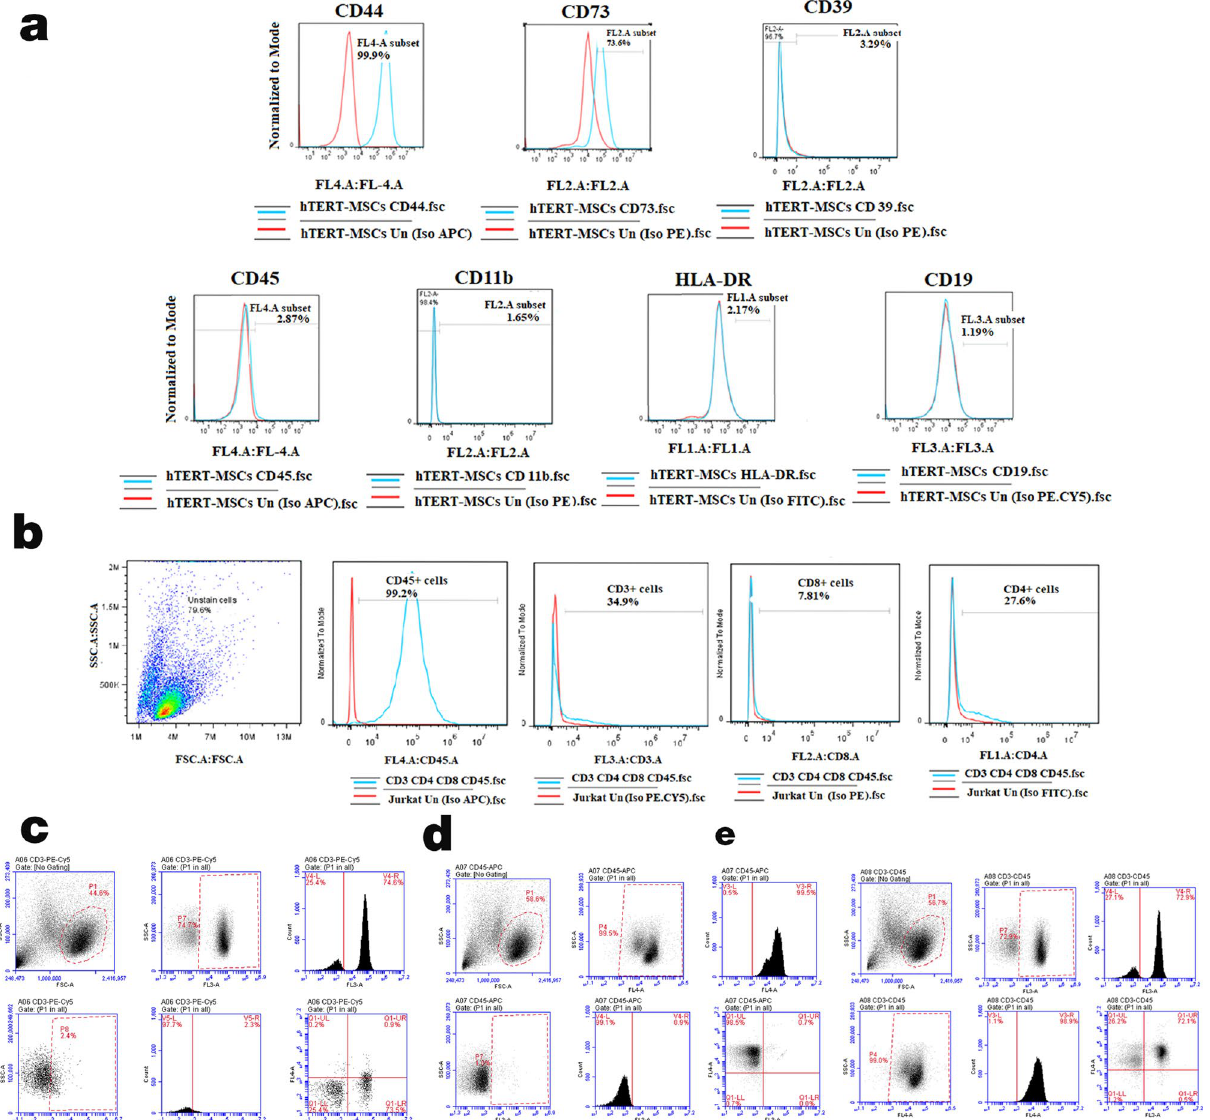
Figure 1. Flow cytometric characterization of different cells. ( a ) hTERT-MSCs: hTERT-MSCs were positive for CD44 and CD73, but they were negative for CD45, CD11b, HLA-DR and CD19 markers. ( b ) Jurkat cells: Most (99.2%) of the Jurkat cells express the hematopoietic cell marker CD45, and 34.9% of the total cell population are CD3 + . About 90% of these CD3 + cells are also positive for CD4 expression. ( c – e ) Human PBMCs: About 9% of the cells were positive for CD45 and about 73% of the cells were CD45 + CD3 + . Monocytes and platelets were mostly removed by centrifugation steps before analysis. PI staining was applied to remove dead cells from analysis. Data were obtained by BD Accuri C6 and analyzed using FlowJo Software (version 7.6, Becton, Dickinson and Company;